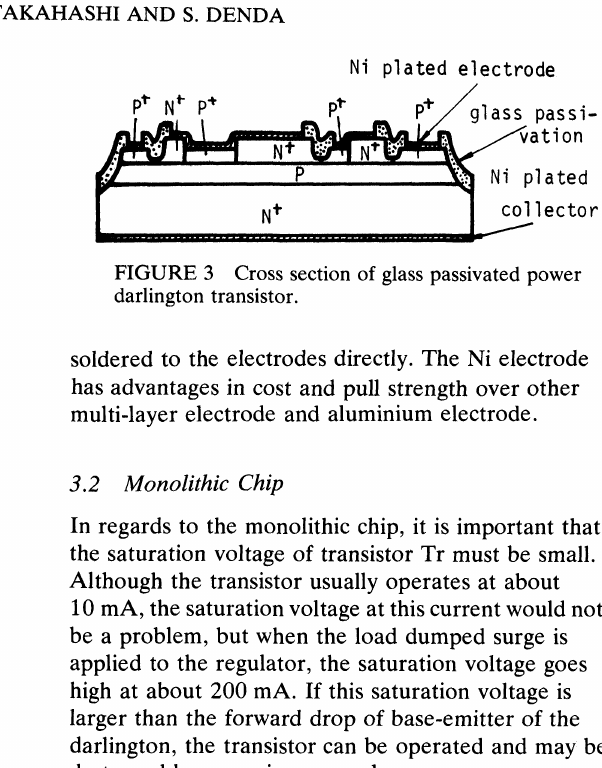
FIGURE 3 Cross section of glass passivated power darlington transistor.